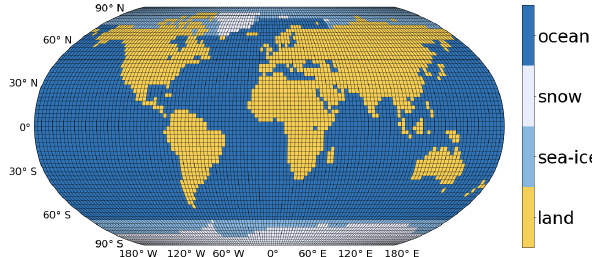
Figure 1. Land, sea, and ice configuration with T42 resolution for 1950CE as used in modern model runs and given by Zhuang et al. (2017a). Four surface types are differentiated: ocean, land surface, sea ice, and land-based ice or